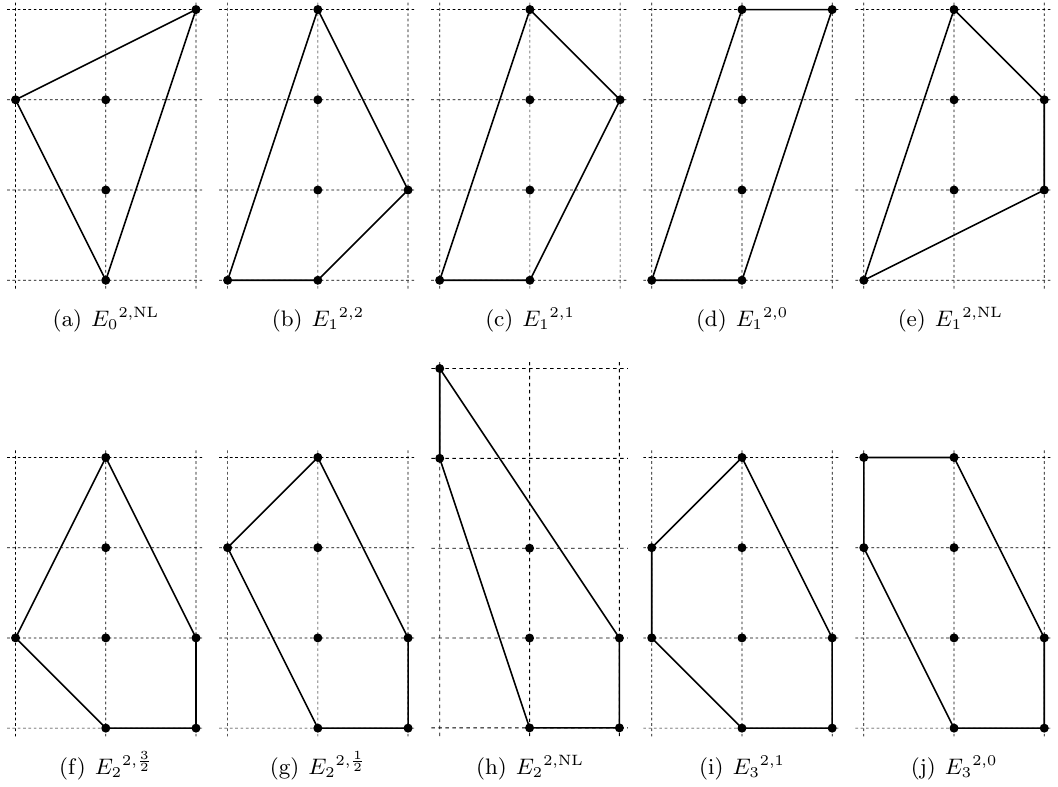
Figure 3 . The 10 SL(2 ; Z )-inequivalent isolated toric rank-2